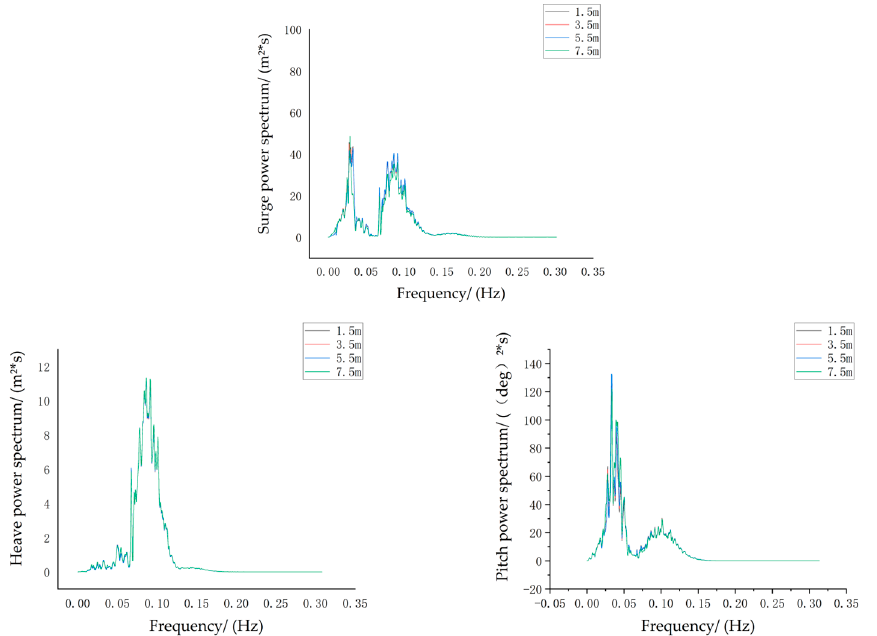
Figure 11. Frequency domain motion comparison with different auxiliary rope fairlead positions under storm self-survival conditions.